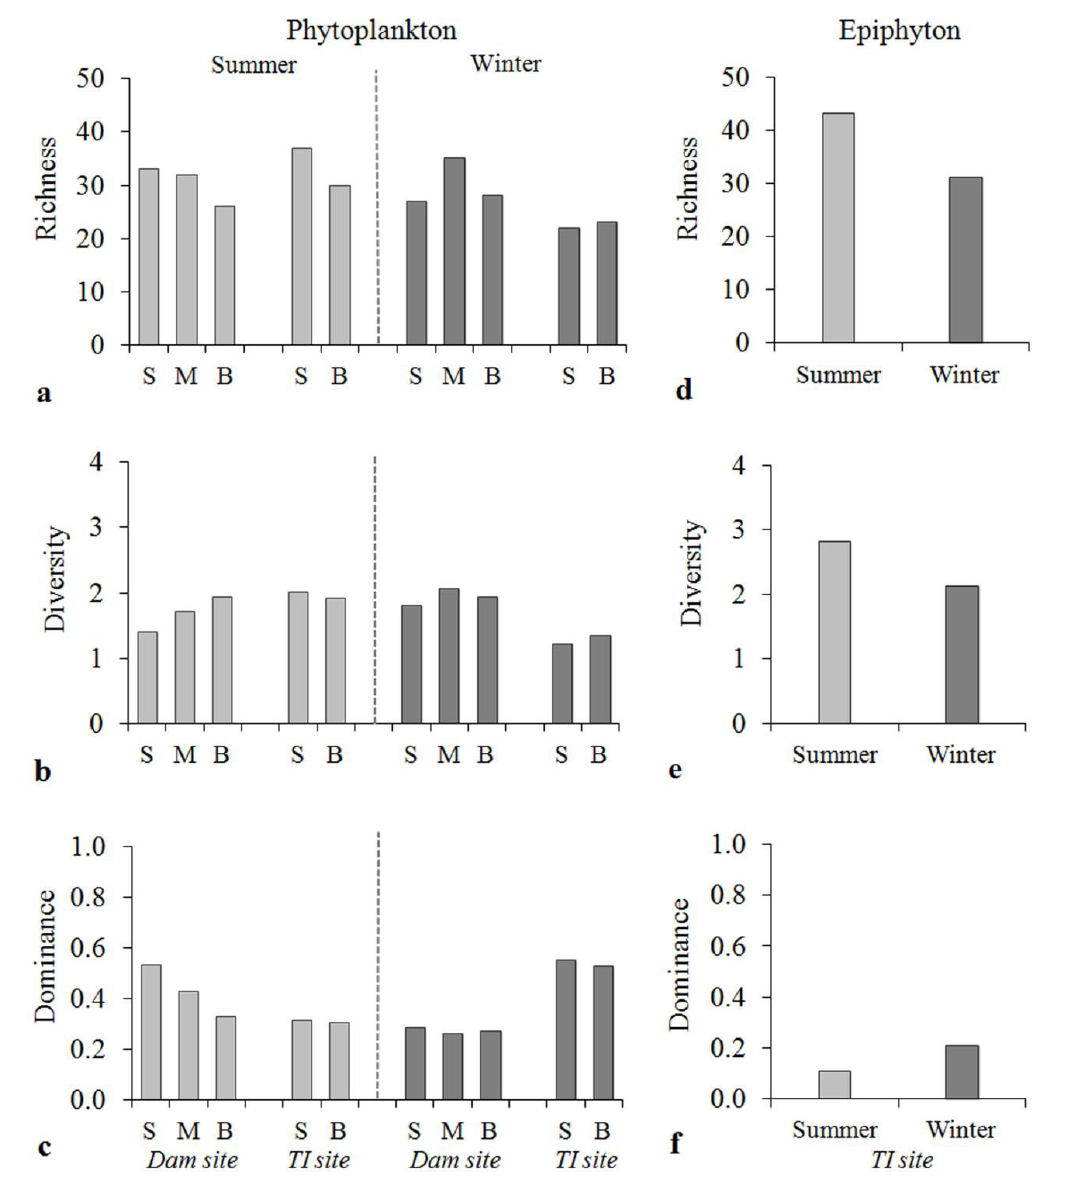
Figure 5. Species richness, diversity and dominance of phytoplankton ( a-c ) and epiphyton ( d-f ) in an urban hypereutrophic reservoir during the study period (S: subsurface, M: middle, B: